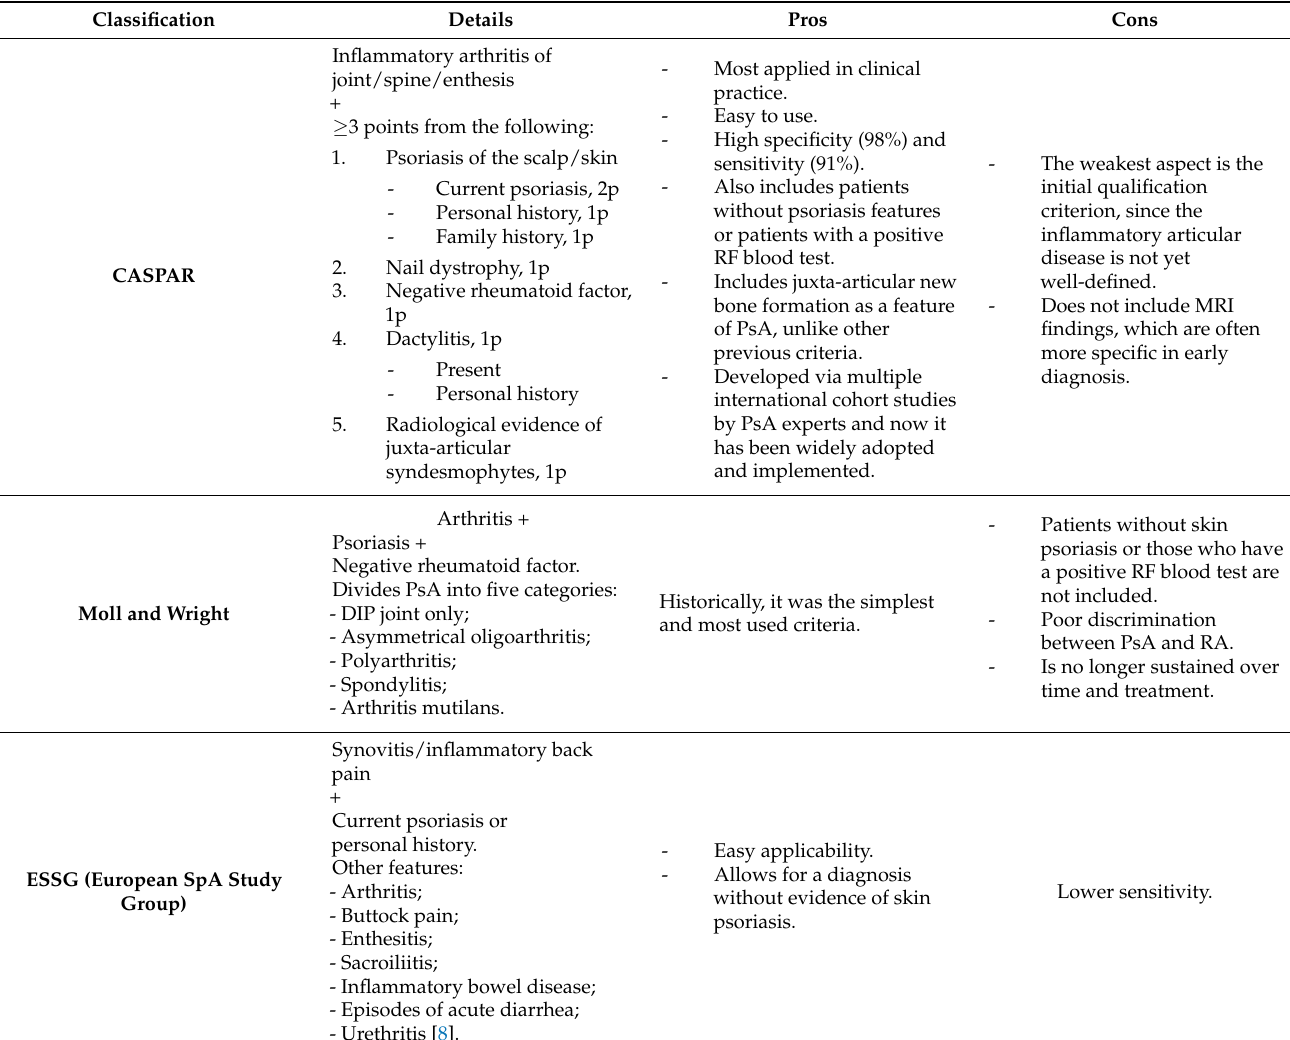
Table 3. List of PsA